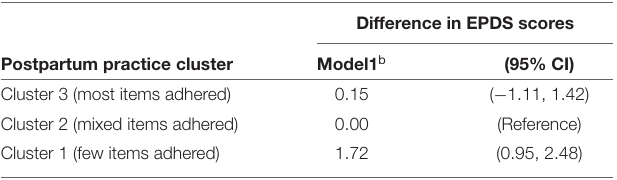
TABLE 4 | Mean difference in EPDS scores according to postpartum practice cluster patterns a